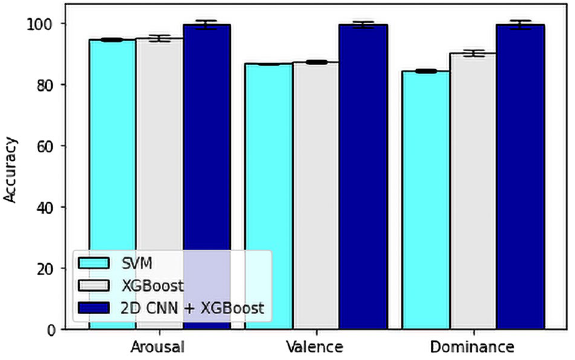
Figure 13. Mean accuracy comparison of arousal, valence and dominance among (i) feature fusion-based SVM method (ii) feature fusion-based XGBoost method, and (iii) the proposed spectrogram image-based CNN- XGBoost fusion